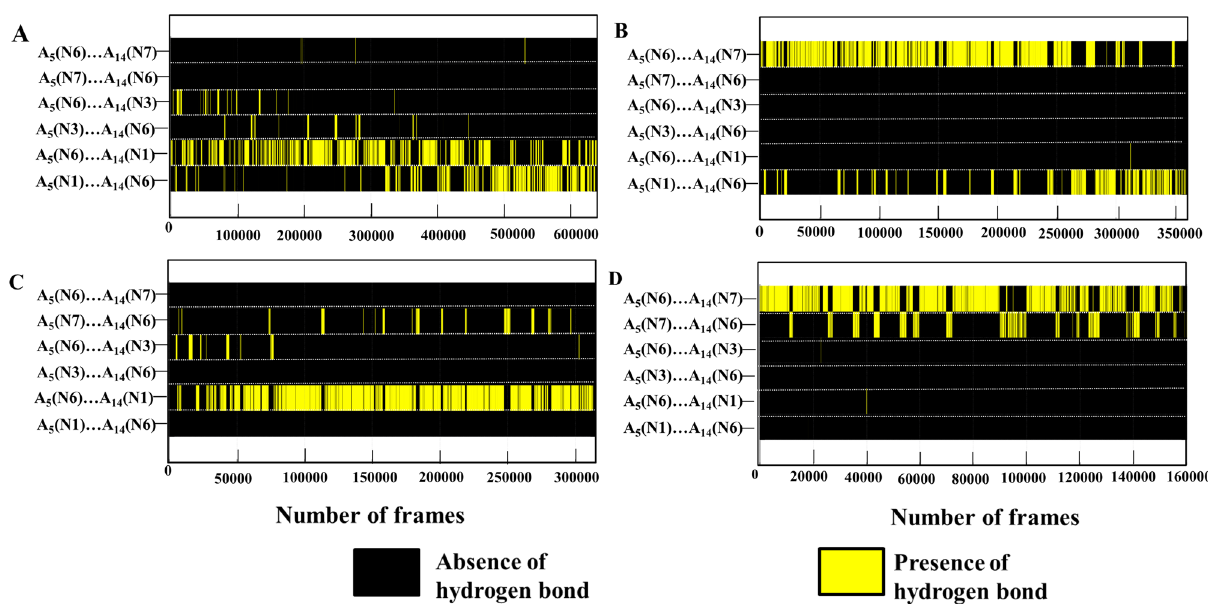
Figure 7. Hydrogen bond lifetime profiles corresponding to the energetically favored regions of the free energy map (dotted boxes in Fig. 6). The hydrogen bond profile representing the dynamics of A 5 …A 14 in ( A ) anti… anti ( χ 5 and χ 14 each has 16 × 16 = 256 windows in this region, wherein, each window has 2500 frames), ( B ) anti… + syn, ( C ) + syn …anti and ( D ) + syn… + syn regions. Note that the windows (each window has 2500 frames) corresponding to each region are arranged adjacent to each other and are represented in terms of the total number of frames along the X-axis. Refer to the text for details. The GNUPLOT 5.2 software was used to plot the data 54